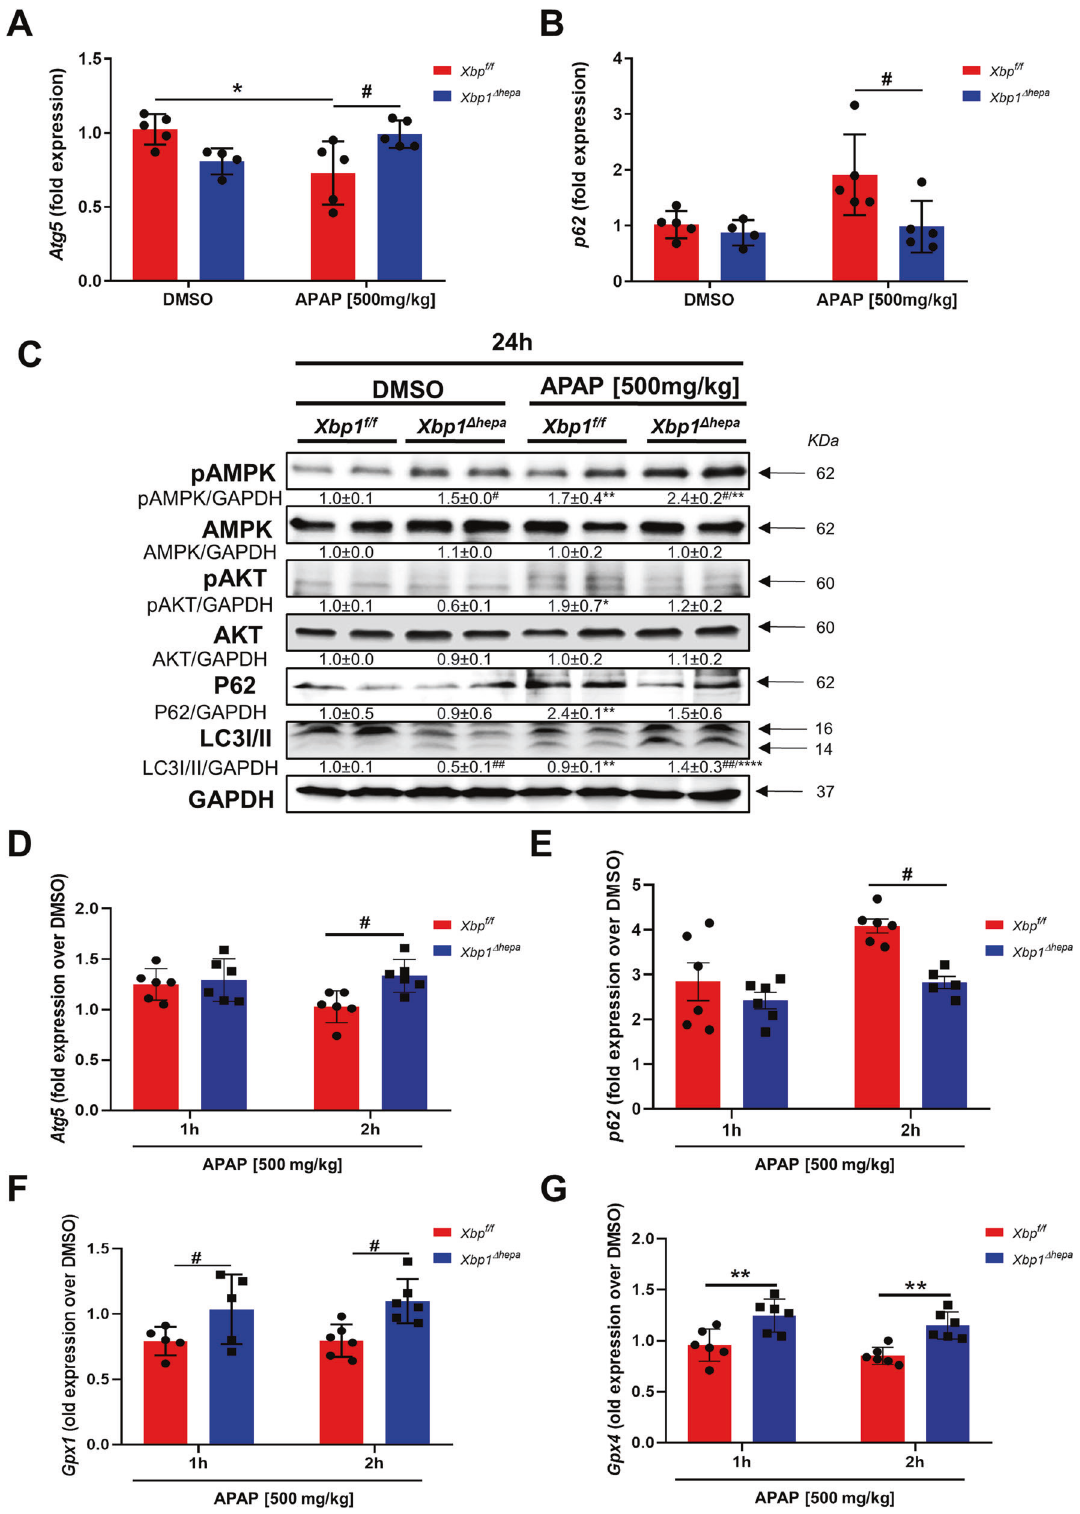
Fig. 4 Loss of Xbp1 in hepatocytes promotes autophagy after APAP treatment. Xbp1 f/f and Xbp1 Δ hepa mice were challenged with APAP [500 mg/kg] at late (24 h) and early (1 – 2 h) stages of hyperacute liver injury. A , B mRNA levels of Atg5 ( A ) and p62 ( B ) were determined by RT- qPCR, 24 h post-APAP. C Protein levels of pAMPK, AMPK, pAKT, AKT, P62, and LC3I/II were analyzed by western blot in liver extracts of the same mice. GAPDH was used as a loading control. Relative protein levels were quanti fi ed using ImageJ software. D – G mRNA levels of Atg5 ( D ), p62 ( E ), Gpx1 ( F ), and Gpx4 ( G ) were determined by RT-qPCR. Data are expressed as mean ± SEM ( N = 4 – 5 per experimental group; intragroup, # intergroup; p < 0.05-**** p < 0.0001; # p < 0.05- ### p < 0.0001).